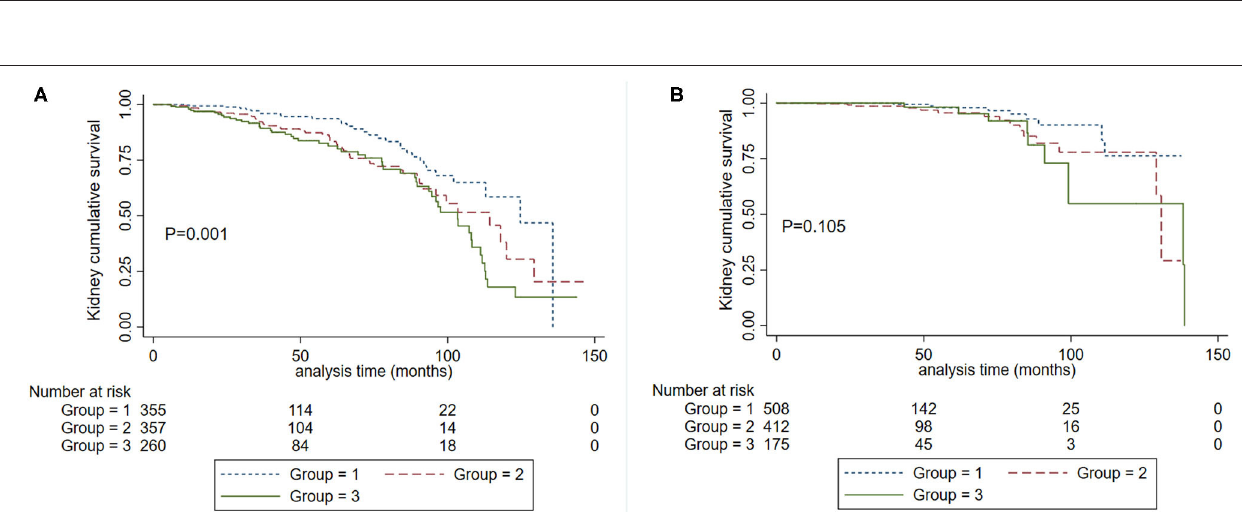
Frontiers in Medicine |